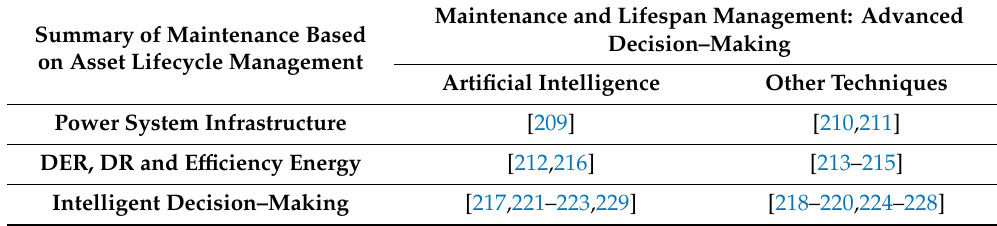
Table 9. Summary of Advanced Decision–Making